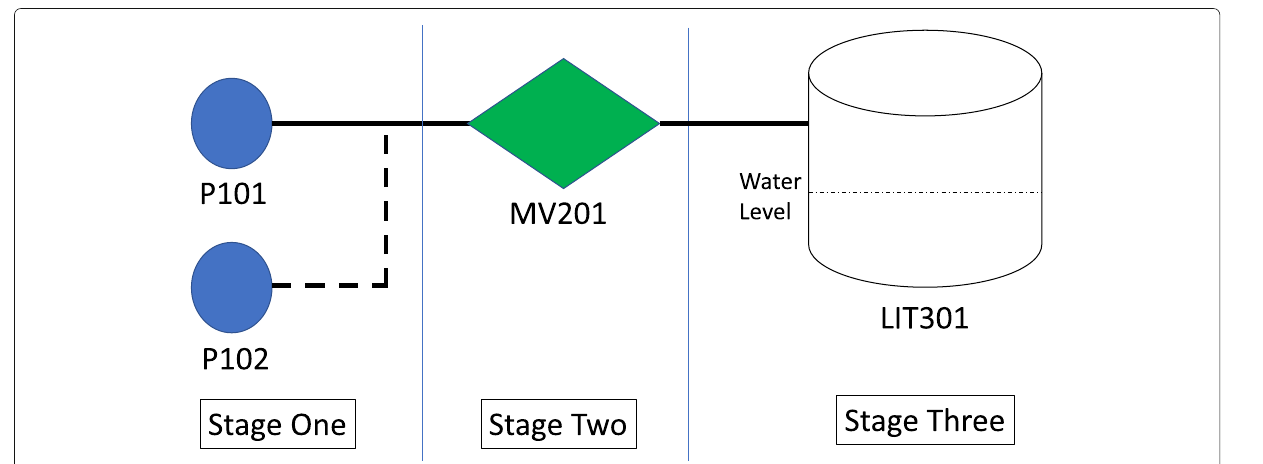
Fig. 8 Attacks #2-#5 on SWaT: including SAOS, MAOS, and MAMS attacks